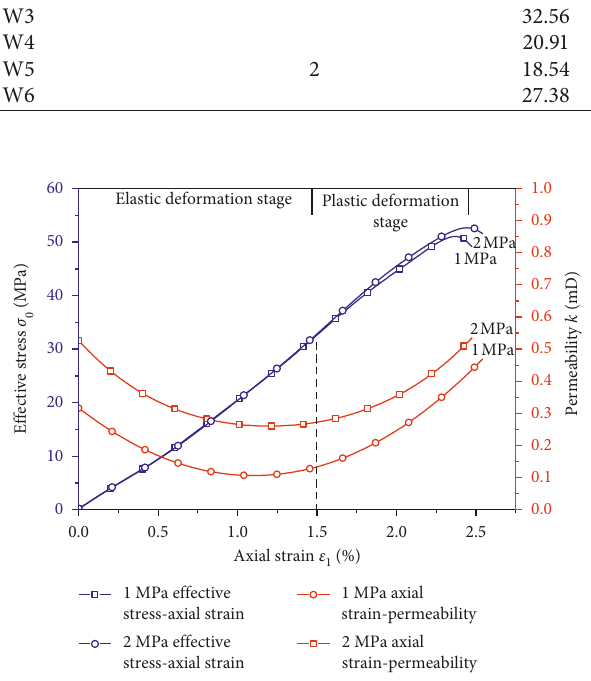
Figure 6: Relationships between effective stress, permeability, and axial strain at a confining pressure of 6